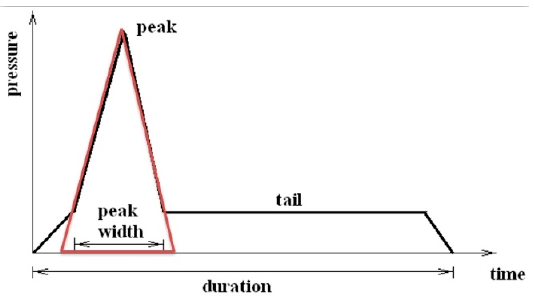
Figure 21. Simplified triangular pressure.